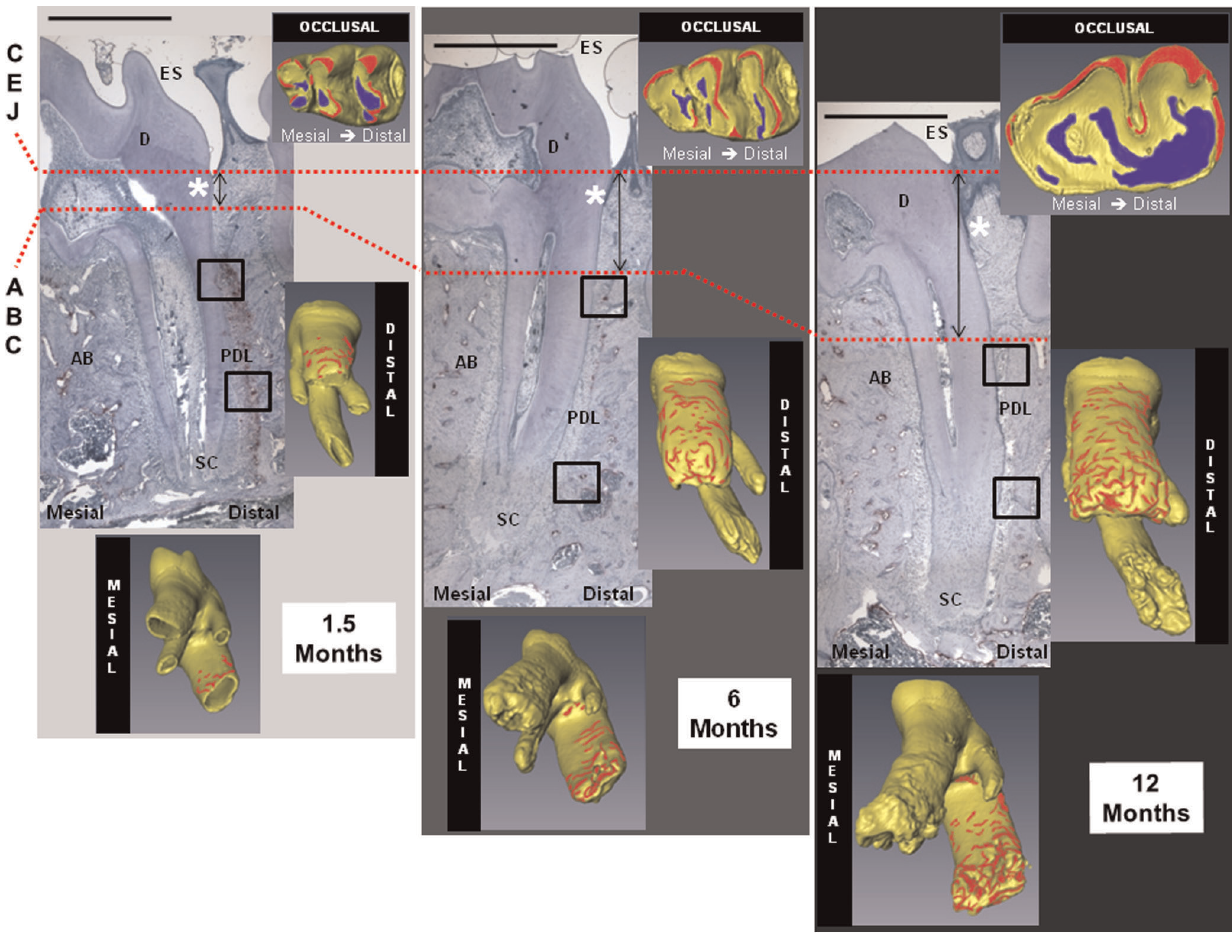
Figure 1. Morphological changes and anatomical locations within TRAP positive cells. Morphological changes were observed in histological sections and confirmed in three dimensional space using a MicroXCT (shown in insets comparing occlusal, distal, and mesial surfaces). The distal preference of TRAP positive cells and progressive mesial curving were observed. Anatomical structures include enamel space (ES), dentin (D), periodontal ligament (PDL), alveolar bone (AB), and secondary cementum (SC). TRAP stained micrographs at 4X magnification show first molar distal roots decreasing in osteoclast intensity and frequency with age. Representative coronal and apical TRAP positive areas in the encircled regions are enlarged in Figure 3. With age, a transition from CEJ to DGJ (demarcated by white asterisk) and increasing recession (CEJ-ABC distance represented by distance between dashed red lines) were observed. Scale bar=1 millimeter. CEJ: cementoenamel junction; DGJ: dentin gingival junction; ABC: alveolar bone